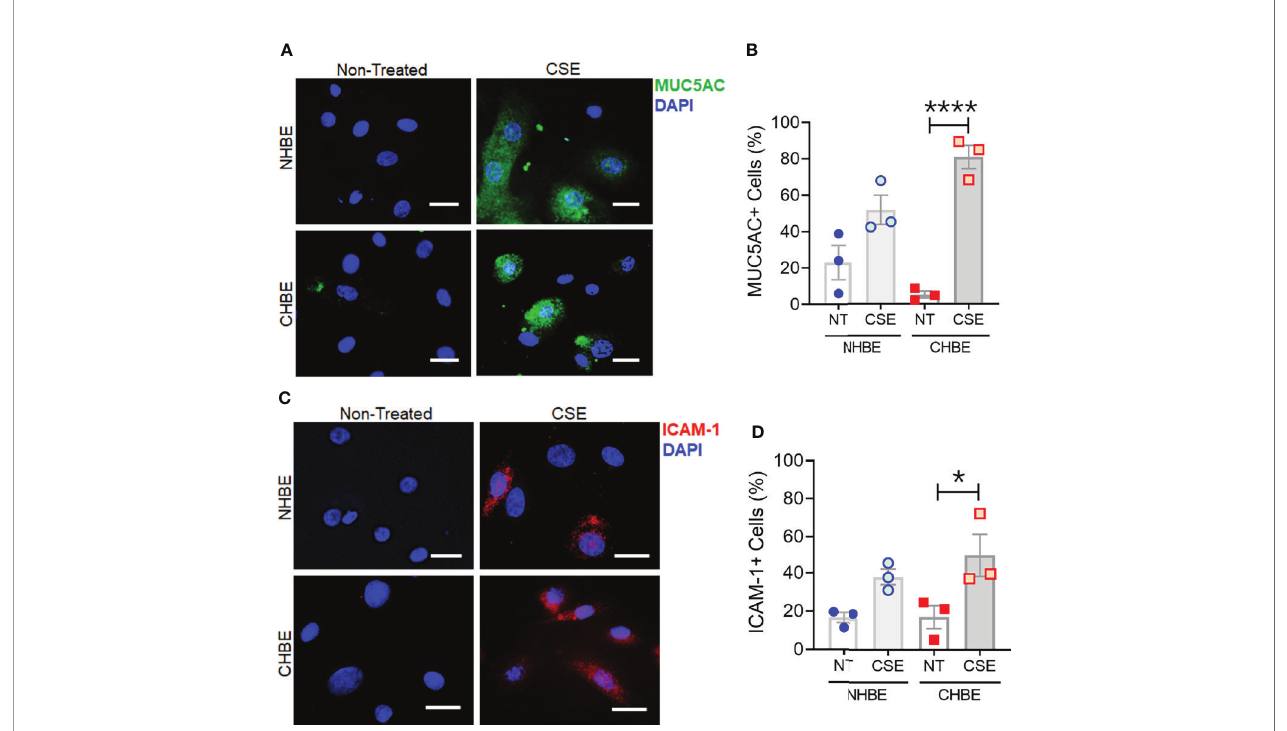
FIGURE 5 | Cigarette smoke treatment augments mucous cell hyperplasia in CHBEs with higher ICAM-1 protein expression compared to non-COPD control cells. Primary NHBEs and CHBEs grown in LabTek-II ® slides were treated with a 20 µg/ml CSE and forty-eight hours after treatment cells were fi xed with 4% paraformaldehyde (PFA) and processed for staining with antibodies against MUC5AC and ICAM-1. (A) Representative micrographs showing MUC5AC immunopositivity (shown in green) in NHBEs and CHBEs treated with CSE or left non-treated (NT), and nuclei were stained by DAPI (shown in blue), scale – 10µm. (B) Quanti fi cation of MUC5AC-positive (+) cells in NHBEs and CHBEs treated with CSE compared to NT cells. (C) Representative micrographs showing ICAM-1 immunopositivity (shown in red) in NHBEs and CHBEs treated with or without CSE, scale – 10 µm. (D) Quanti fi cation of ICAM-1-positive (+) cells in NHBEs and CHBEs treated with CSE compared to NT controls. Data shown as mean ± SEM as fold-change compared to NT cells; n=3/gp; data analyzed by ANOVA; * p <0.05; **** p